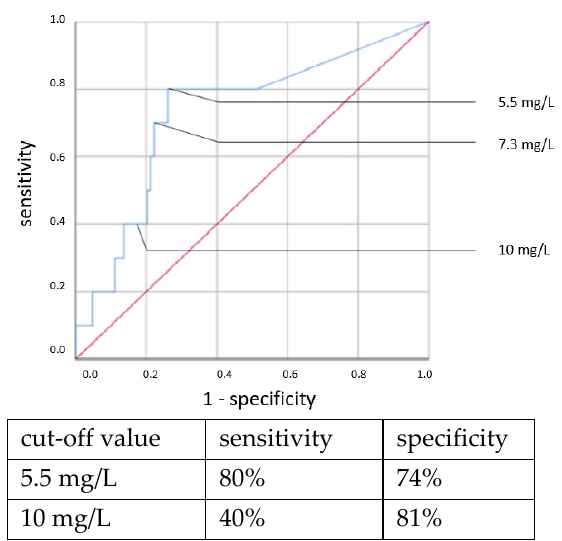
Figure 5. CRP concentration at the time of sepsis workup. Culture-positive EOS.